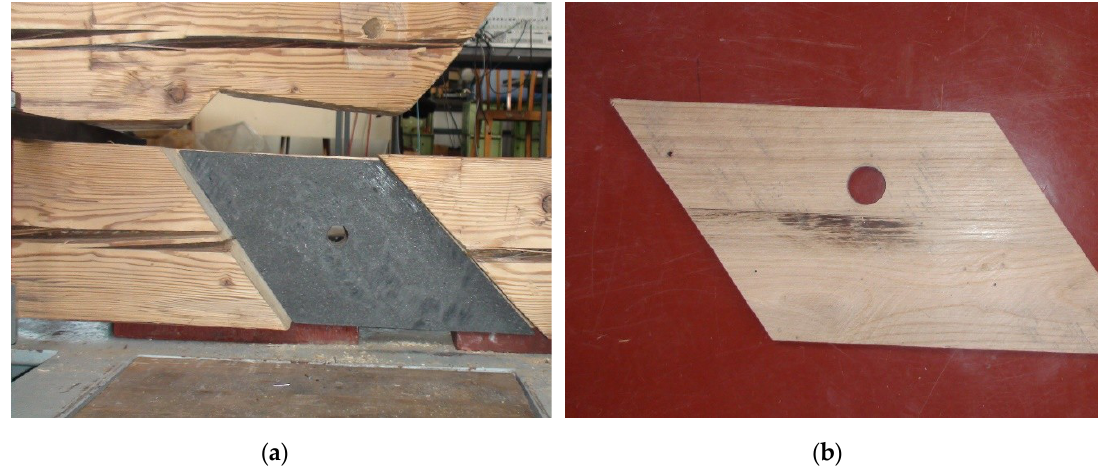
Figure 5. ( a ) J oint retrofitting with brake friction plate and replacement of the oak pin by a pre-stressed steel screw bolt; ( b ) an oak plate for joint retrofitting with friction plates.